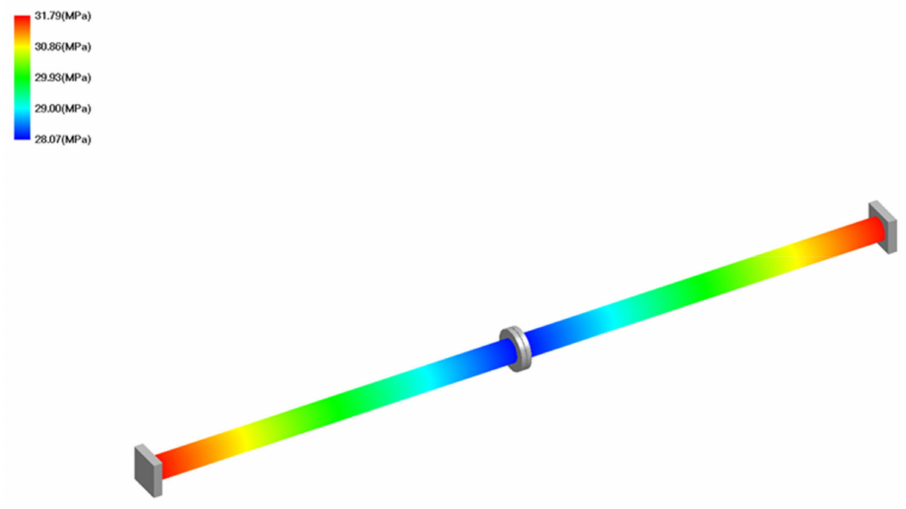
Figure 3. Example of graphical results: sustained stress σ 1 (MPa) for L = 1880 mm.